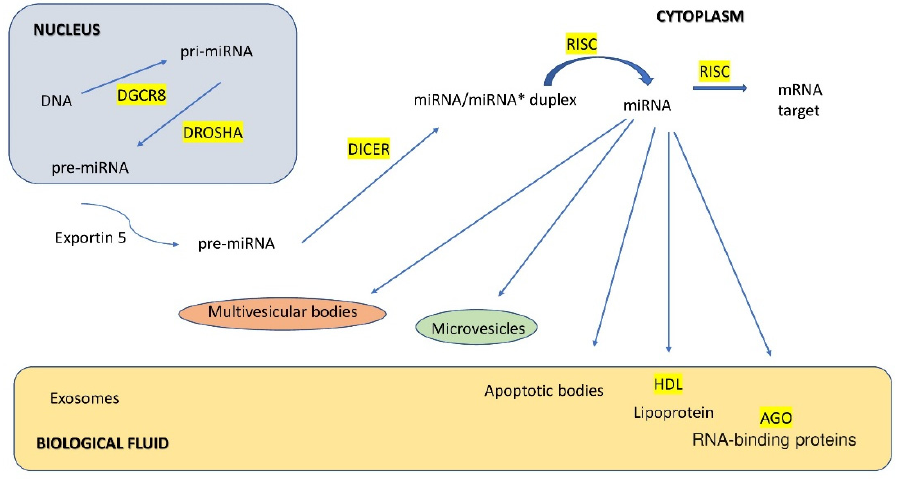
Figure 2. miRNA biogenesis.